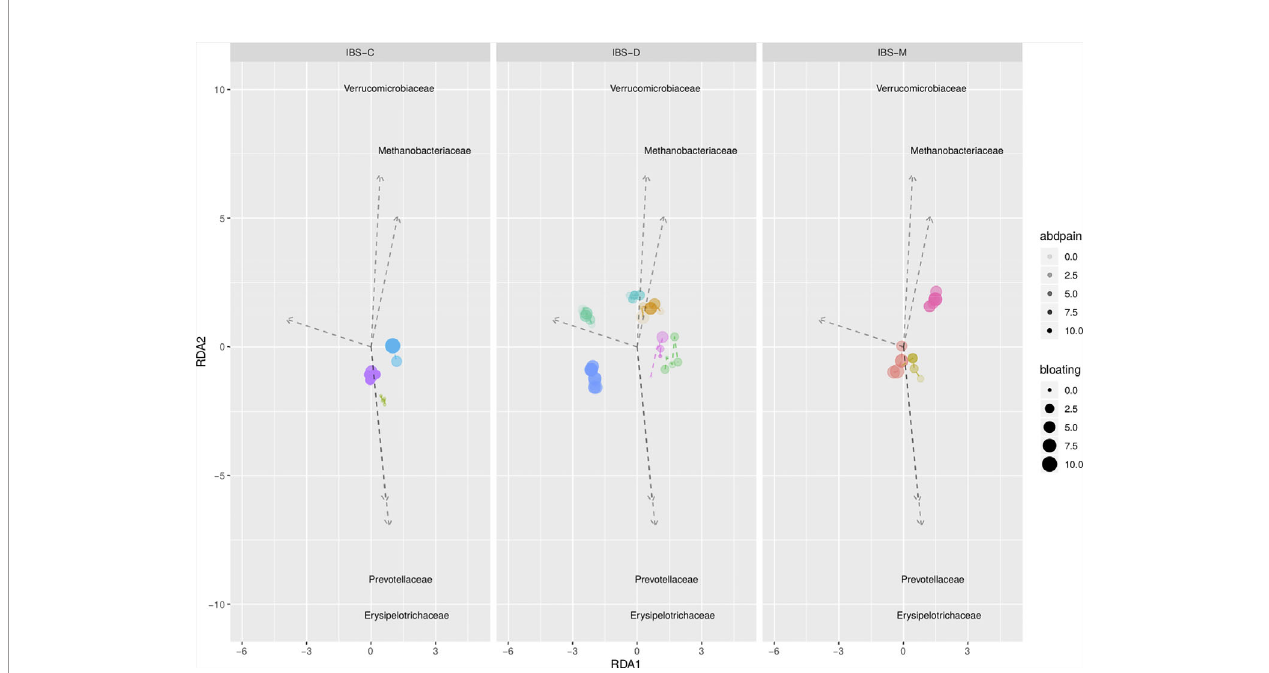
FIGURE 3 | Redundancy analysis plot based on clr transformed abundancies, and constrained on individual, abdominal pain, and abdominal bloating. Each dot represents an individual sample; IBS patients are depicted by different colors. No signi fi cant association between both GI symptoms (p = 0.368 for abdominal pain; p = 0.521 for bloating) and microbial